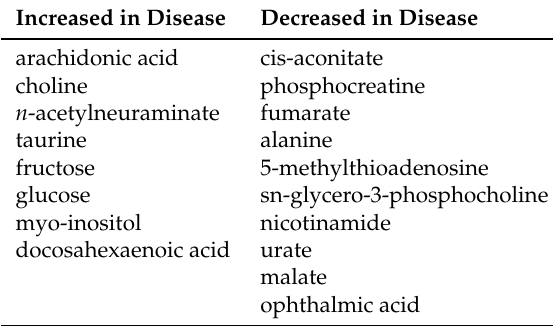
Table 5. ST000741, Metabolites increased in cultures from patients with severe disease.